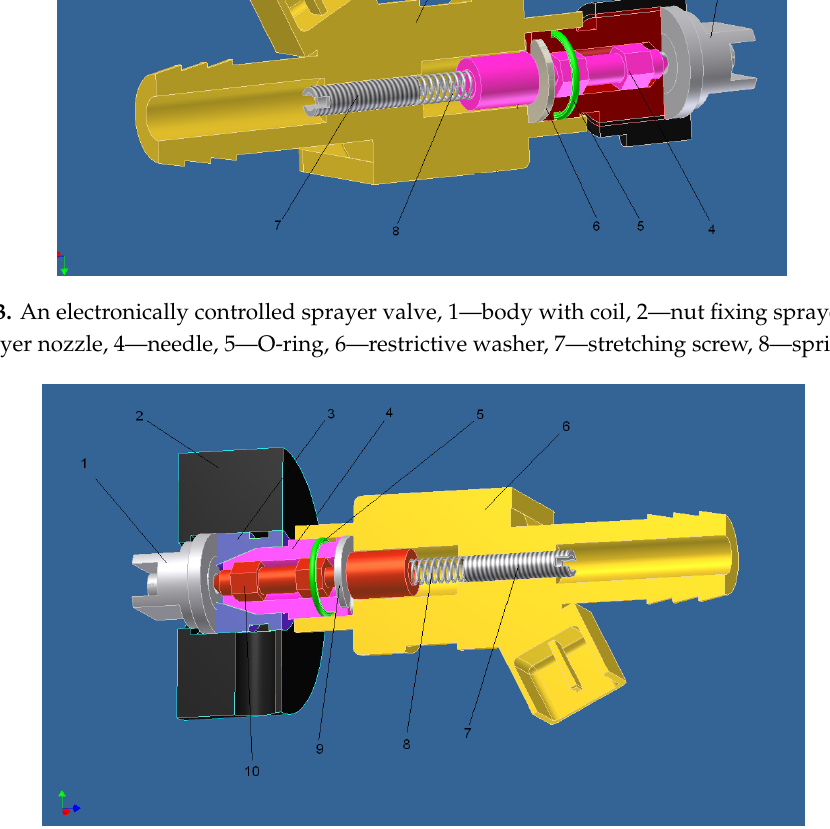
Figure 4. An electronically controlled sprayer valve with an additional supply of compressed